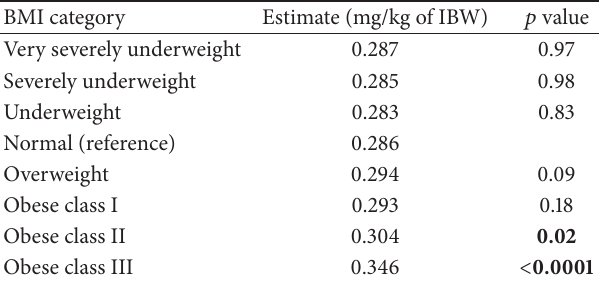
Table 2: Univariate linear mixed effects model using BMI category as a predictor for rocuronium maintenance dose in mg/kg of IBW. All patients should receive similar doses based on IBW, but in this study obese patients received higher doses.